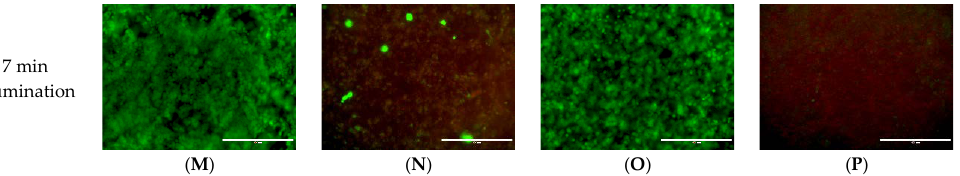
Figure 8. Live-Dead images of HEY 3D cultures post PDT (0.4 µg/mL) ( B , F , J , N ), dactinomycin only (1 nM) ( C , G , K , O ) and combination treatment ( D , H , L , P ) using different light conditions, and ( A , E , I , M ) without light. The cultures were treated using a blue lamp at wavelength of 420nm and light power of 7 mW/cm 2 . The total light doses used were 1.26 J/cm 2 (3 min), 2.1 J/cm 2 (5 min) and 2.94 J/cm 2 (7 min). Live-Dead assay was applied 48 h after illumination. To stain the live (green) and dead (red) cells, the 3D constructs were incubated with a solution containing Calcein-AM (live) and Ethidium homodimer-1 (dead). The scale bar presented in each image is 400 µm.